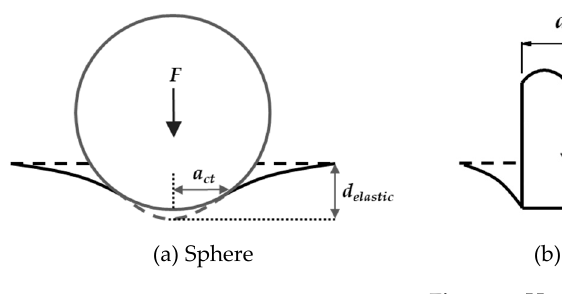
Figure 7. Hertz contact.